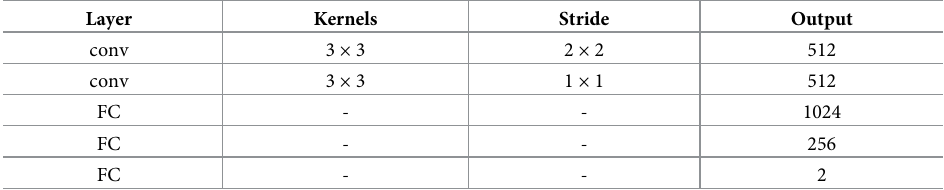
Table 1. Parameter settings of semantic segmentation